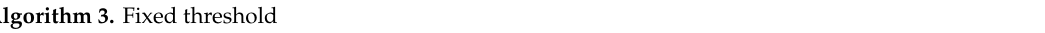
Figure 8. Cross-correlation between different algorithms ( N = 10). The maximum coefficients when considering the time-shift, where th = −0.5 mV and s win = 0.2 s, are shown. ( a ) Box plots of cross-correlation coefficients; the top and bottom sides of a box indicate the first and third quartiles, and the bar represents the median. The whiskers indicate the maximum or minimum values. Plots with different letters indicate significant differences between them ( P < 0.05, Steel–Dwass test). Fixed